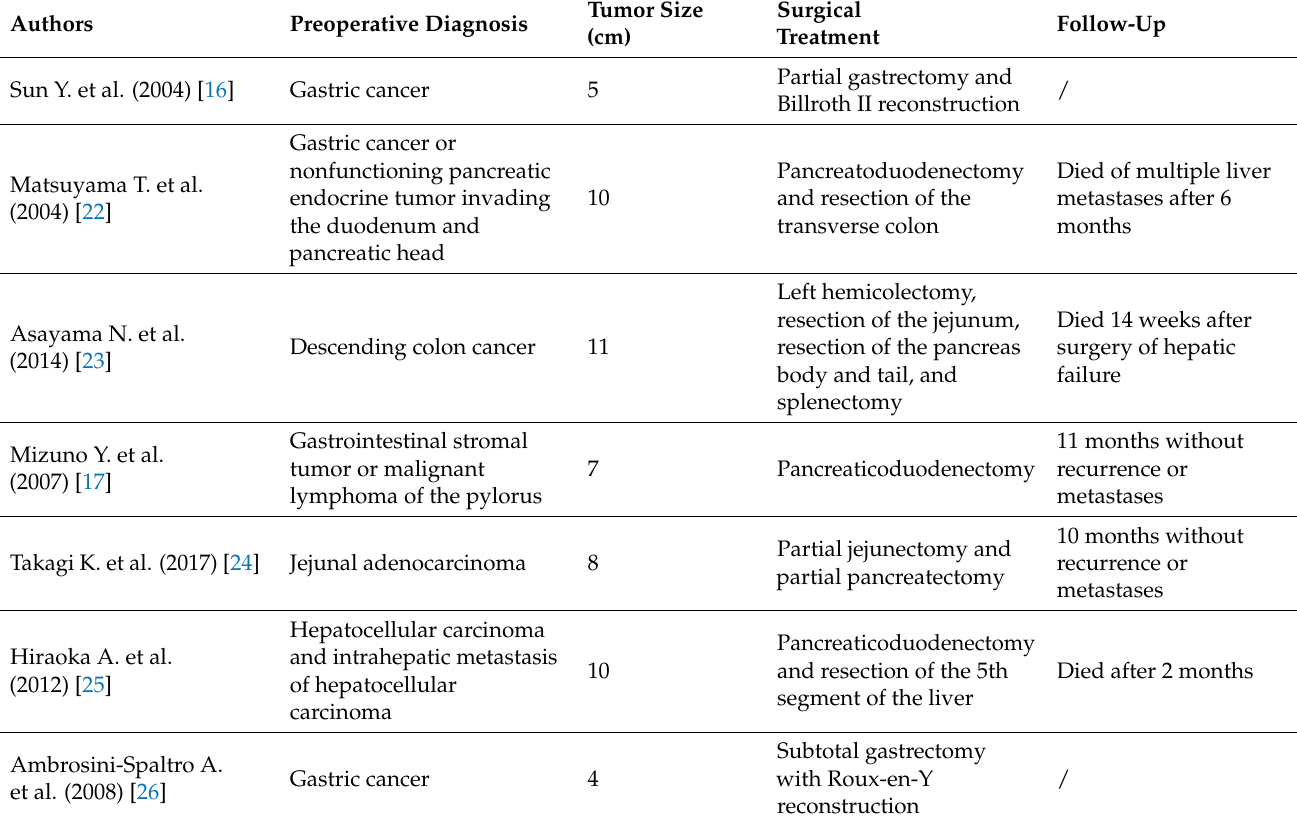
Table 1. Case reports of PACC with extensive involvement of adjacent organs and misunderstood preoperative